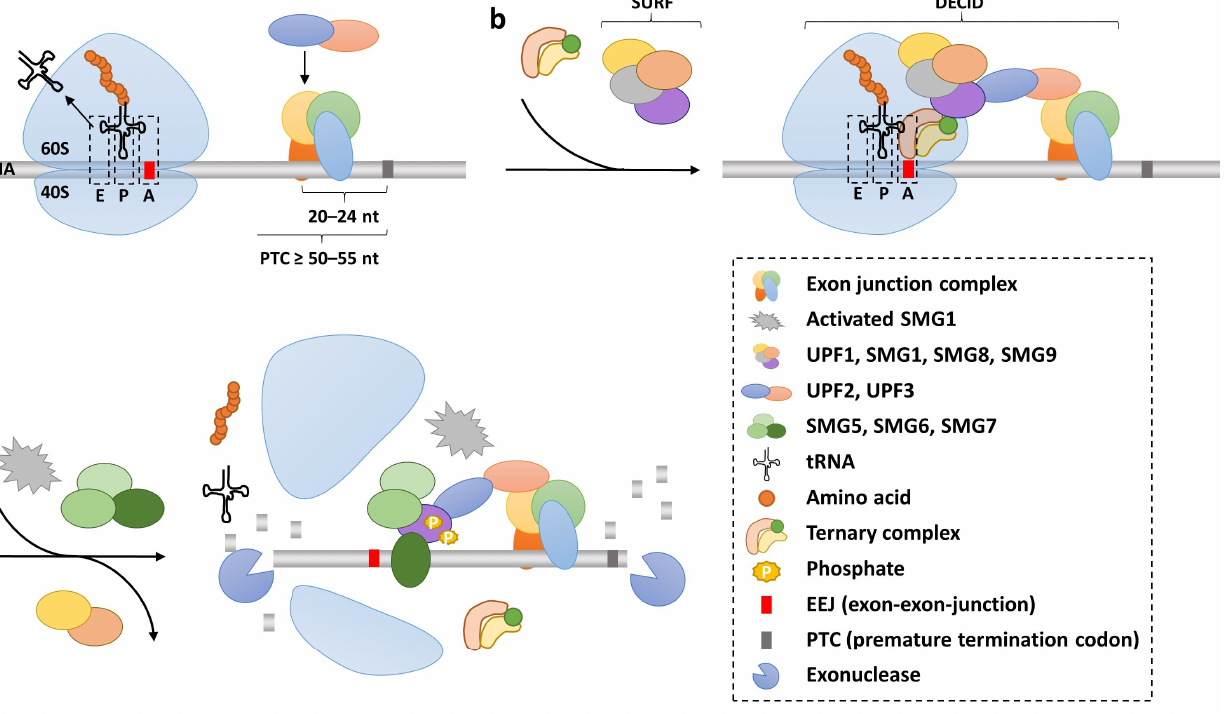
Figure 2. Premature termination of translation and initiation of nonsense mediated decay. ( a ) The ribosome is halted by the premature termination codon (PTC) motive located at least 50–55 nt upstream of an exon–exon junction (EEJ) and this is reinforced by an exon junction complex. The ternary complex enters the A-site of the stalled ribosome, and UPF2 and UPF3 are recruited to the exon junction complex (EJC). The readthrough propensities of different PTCs (UGA, UAG or UAA) as well as the nucleotide immediately succeeding the stop codon (+4 nt) are indicated (green indicates lowest stringency; red indicates highest stringency of translation termination). ( b ) The SURF (SMG1–UPF1–eRF1–eRF3) complex closes the gap between the paused ribosome and the EJC, forming the so-called DECID complex. ( c ) Release of SMG8 and SMG9 from the SURF complex leads to the activation of SMG1, phosphorylation of UPF1, the release of eRF1/eRF3 and the dissociation of ribosomal subunits. Recruitment of decay factors SMG5, SMG6 and SMG7 mediates mRNA nucleolytic digestion.